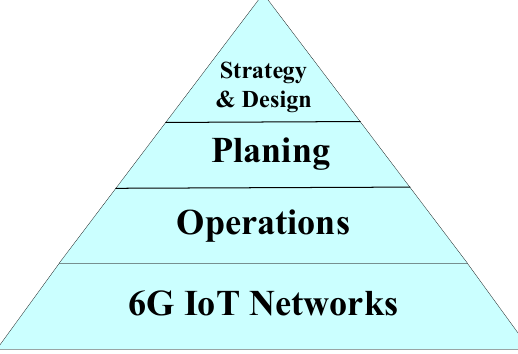
Figure 3. Three decision ‐ making phases in supply chain.